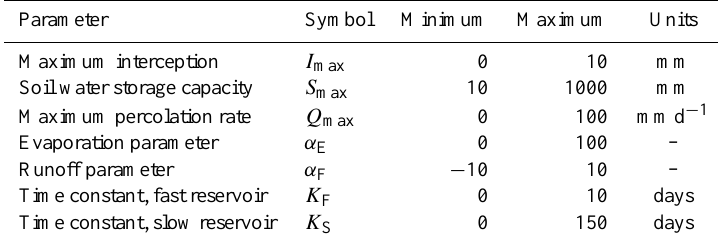
Table 1. Prior uncertainty ranges of hmodel parameters.